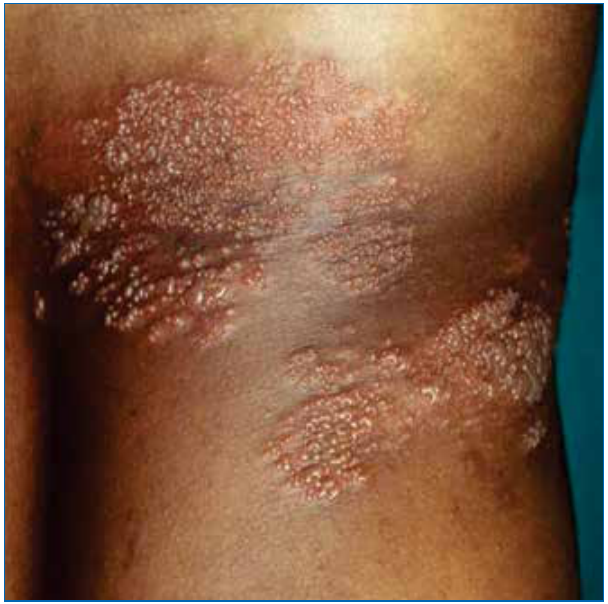
Figure 2: Herpes zoster affecting the trunk.